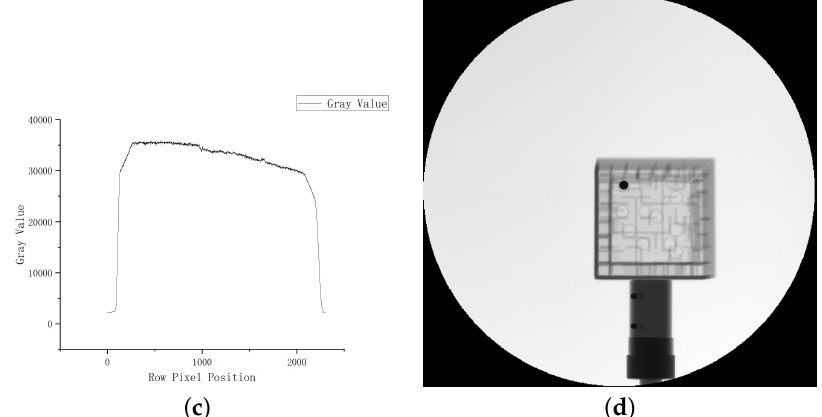
Figure 7. Projection images of normalized processing: ( a ) is the original empty field projection image, ( b ) is the original sample projection image at Rd z = 0 ◦ , ( c ) is the grayscale change trend of the empty field projection image in Figure ( a ) red line , and ( d ) is the processed sample projection image at Rd z = 0 ◦ ; the nonlinear decay of the light intensity improved significantly.